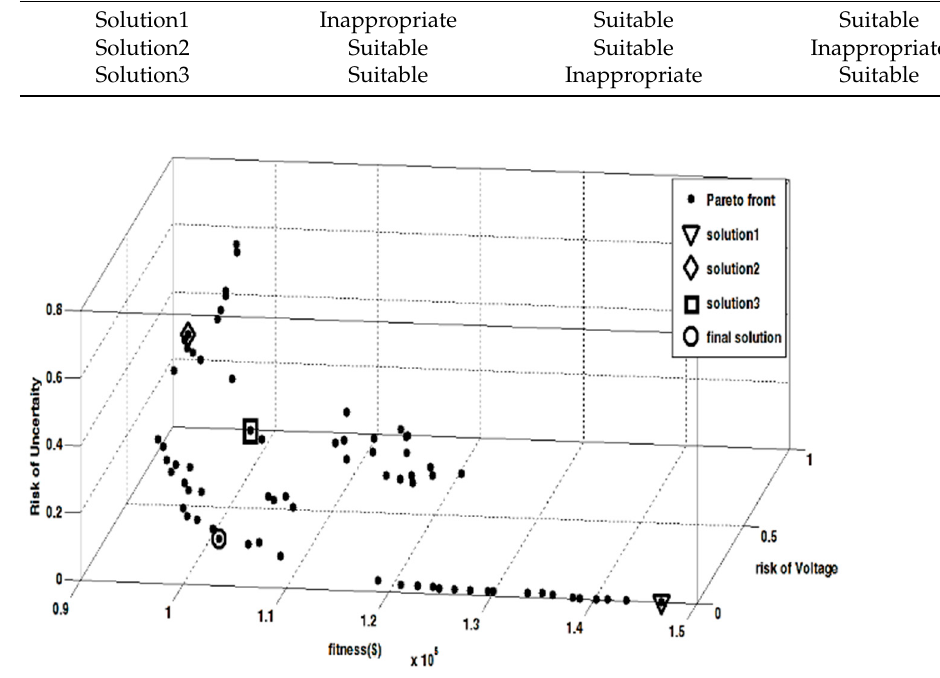
Figure 9. Pareto response space in fixed and switching capacitors placement in the distribution network under study.